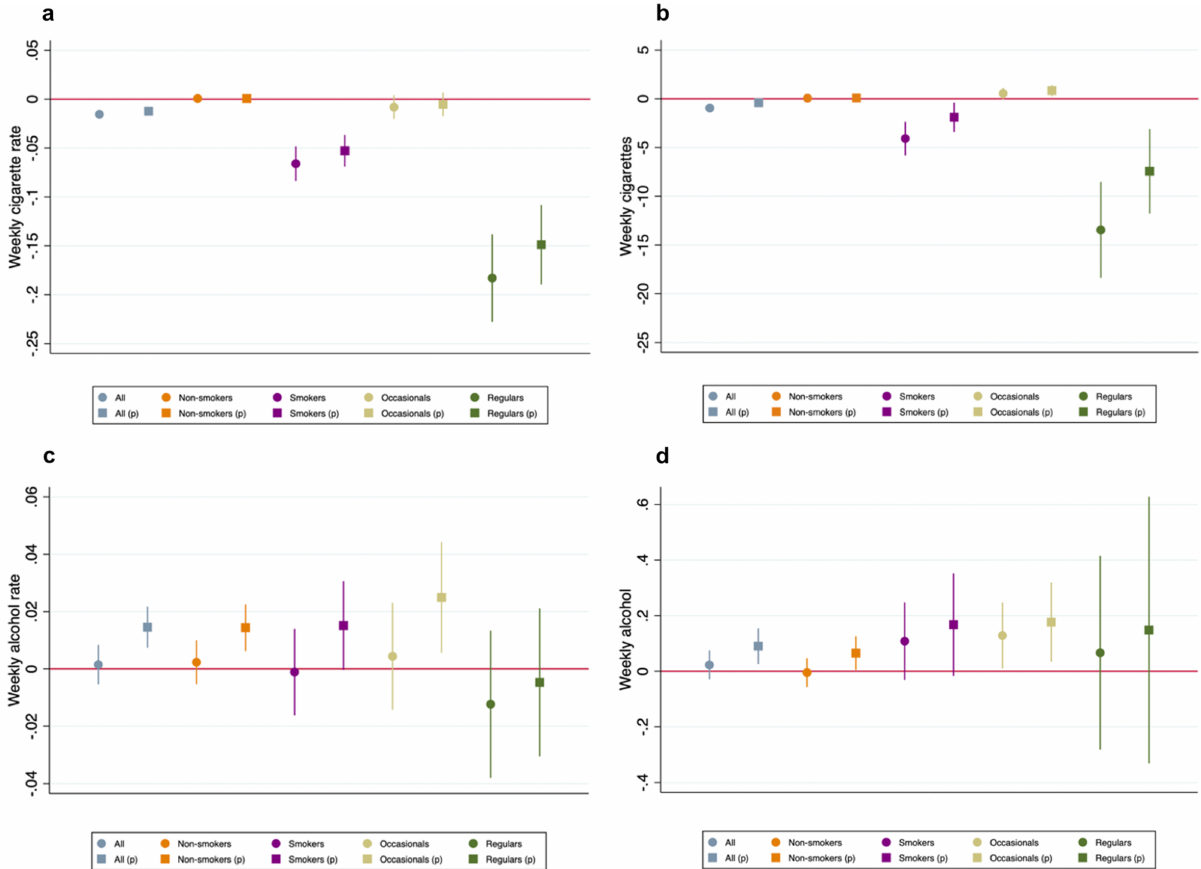
Fig. 2 Estimated Effects of COVID-19 on Cigarette Purchases for Smokers and Non-Smokers. a Estimated impact of COVID-19 on weekly purchase rates of cigarettes; b Estimated impact of COVID-19 on weekly consumption of cigarettes; c Estimated impact of COVID-19 on weekly purchase rates of alcohol; d Estimated impact of COVID-19 on weekly consumption of alcohol. All panels include estimates fi rst without and then with correcting for cigarette prices (estimates controlling price are indicated by “ p ” in parentheses). All coef fi cients are estimated with individual fi xed effects and error terms clustered at the individual level. Error bars shows the 95% con fi dence interval. “ All ” N = 4042; “ Non-smokers ” N = 3059; “ Smokers ” N = 983; “ Occasionals ” N = 658; “ Regulars ” N =